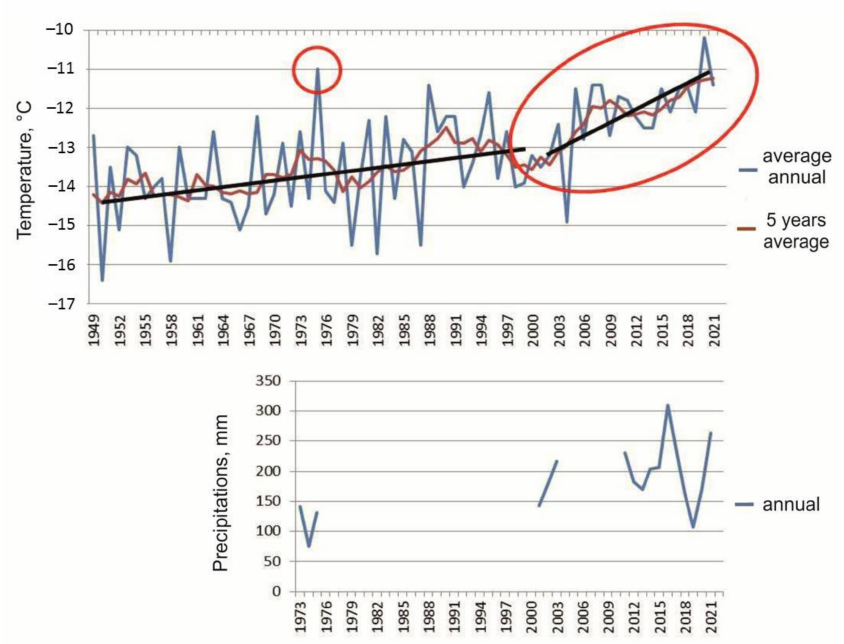
Figure 2. Average annual temperatures and precipitation of the Batagai weather station for the period of instrumental monitoring 1949–2022. (The red circle is a temperature anomaly in 1975. The red oval is a period of a sudden increase in average annual